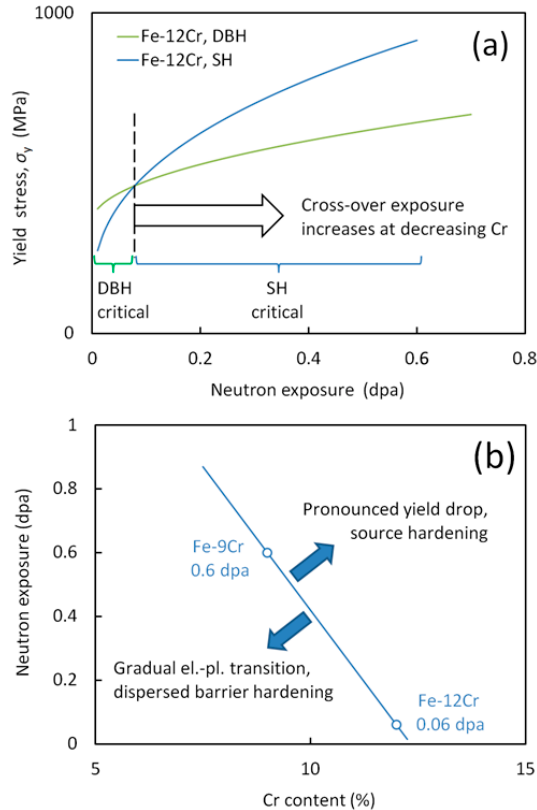
Figure 6. ( a ) Schematic representation of the cross-over from dispersed-barrier hardening (DBH) dominance to source hardening (SH) dominance for Fe-12Cr. ( b ) The mapping of the dominance regions of DBH and SH as function of Cr content and neutron exposure.